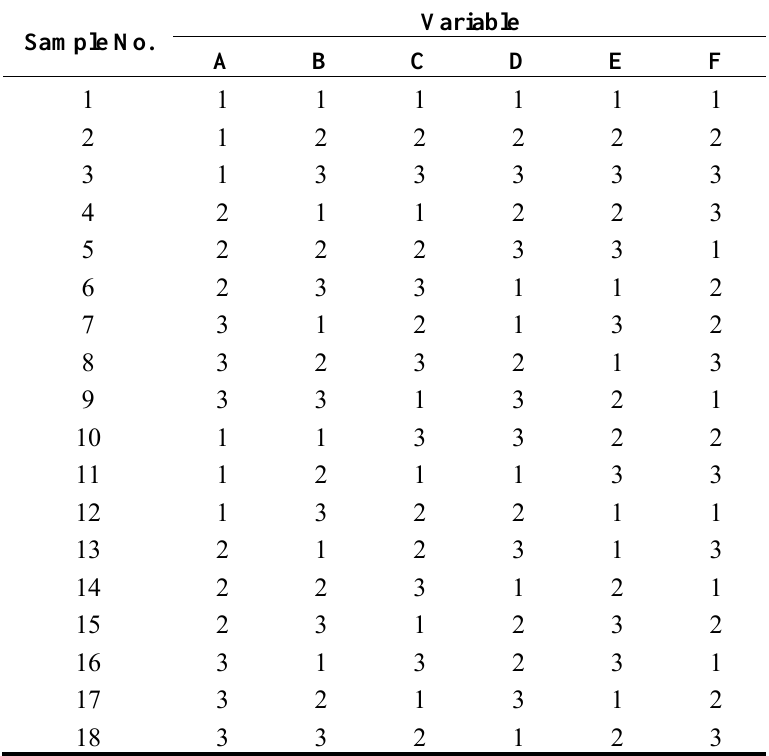
Table 2. Taguchi L18 experimental design: Design